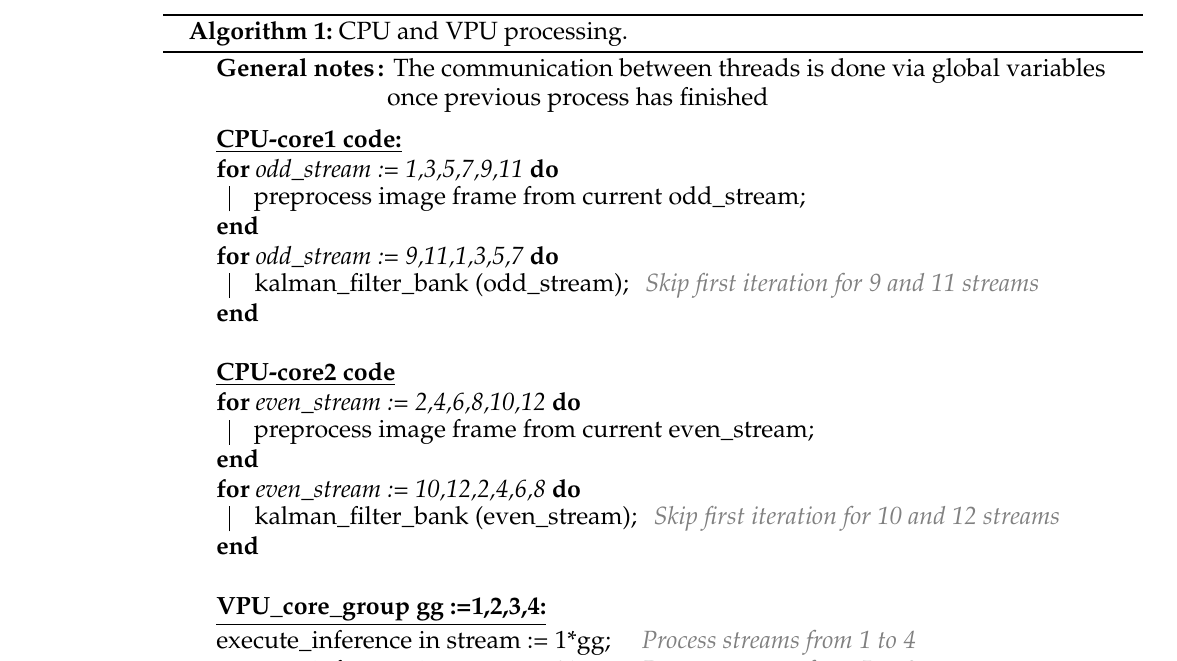
Algorithm 1: CPU and VPU processing.